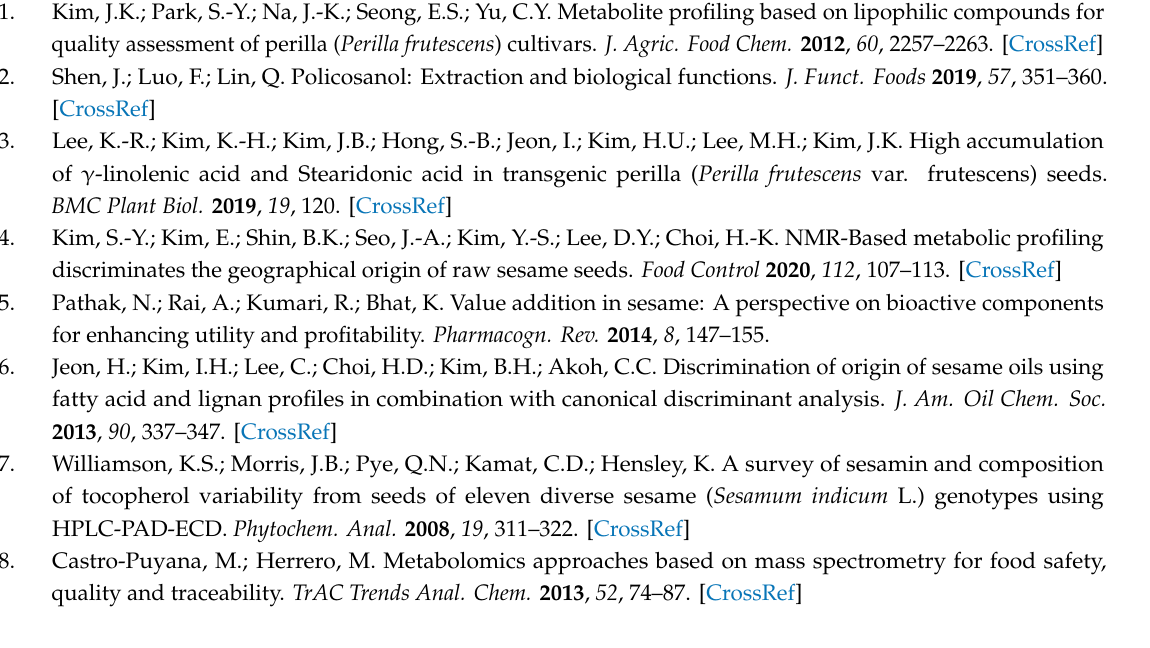
Figure S1: PCA score (A) and loading (B) plots of perilla ( Perilla frutescens ) seeds from Korea and China, Figure S2: PCA score (A) and loading (B) plots of sesame ( Sesamum indicum ) seeds from Korea and China, Figure S3: OPLS-DA score (A) and loading (B) plots of perilla ( Perilla frutescens ) seeds from Korea and China, Figure S4: OPLS-DA score (A) and loading (B) plots of sesame ( Sesamum indicum ) seeds from Korea and China, Figure S5: PCA score plots and Hotelling’s T 2 range column plots of perilla ( Perilla frutescens ) seeds from Korea and China for outlier removal process, Figure S6: PCA score plots and Hotelling’s T 2 range column plots of sesame ( Sesamum indicum ) seeds from Korea and China for outlier removal process, Figure S7: OPLS–DA score plots and VIP (variable importance in the projection) plots of perilla (A) and sesame (B) seeds from Korea and China outlier removal data sets, Table S1: Relative retention times (RRT) and mass spectral data of hydrophilic compounds as trimethylsilyl derivatives, Table S2: Relative retention times (RRT) and mass spectral data of lipophilic compounds as trimethylsilyl derivatives, Table S3: Relative retention times (RRT) and concentration of fatty acid methyl esters (FAME) mixture and fatty acids, Table S4: Composition and content (ratio / g) of hydrophilic compounds in perilla ( Perilla frutescens ) cultivars, Table S5: Composition and content (ratio / g) of hydrophilic compounds in sesame ( Sesamum indicum ) cultivars, Table S6: Composition and content ( µ g / g) of policosanol compounds in perilla ( Perilla frutescens ) cultivars, Table S7: Composition and content ( µ g / g) of policosanol compounds in sesame ( Sesamum indicum ) cultivars, Table S8: Composition and content ( µ g / g) of sterol and terpenoid compounds in perilla ( Perilla frutescens ) cultivars, Table S9: Composition and content ( µ g / g) of sterol and terpenoid compounds in sesame ( Sesamum indicum ) cultivars, Table S10: Composition and content (mg / g) of fatty acids in perilla ( Perilla frutescens ) cultivars, Table S11: Composition and content (mg / g) of fatty acids in sesame ( Sesamum indicum ) cultivars, Table S12: OPLS-DA loading plots and VIP values of variables of perilla ( Perilla frutescens ) cultivars, Table S13: OPLS-DA loading plots and VIP values of variables of sesame ( Sesamum indicum )